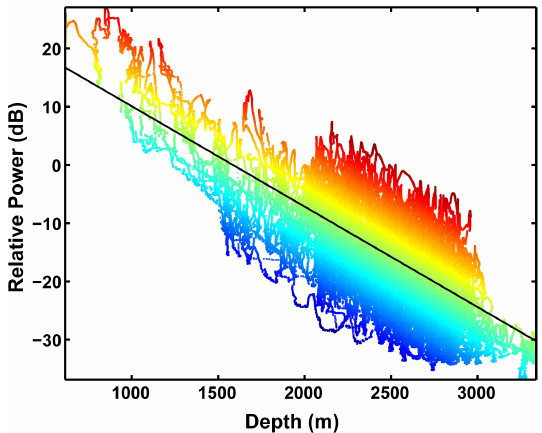
Fig. 2. Detected bed echo power dB for the entire data set of 464000 points, normalized to power from a highly reflective subglacial lake. Linear least squares fit yields a slope of 8 . 6 ± 0 . 1dB/km, the average depth-averaged one-way dielectric attenu- ation. Color scale indicates relative basal reflectivity, the vertical distance of each point from the best fit line. For example, points above the fit line (warm colors) indicate areas of highly reflective (wet)